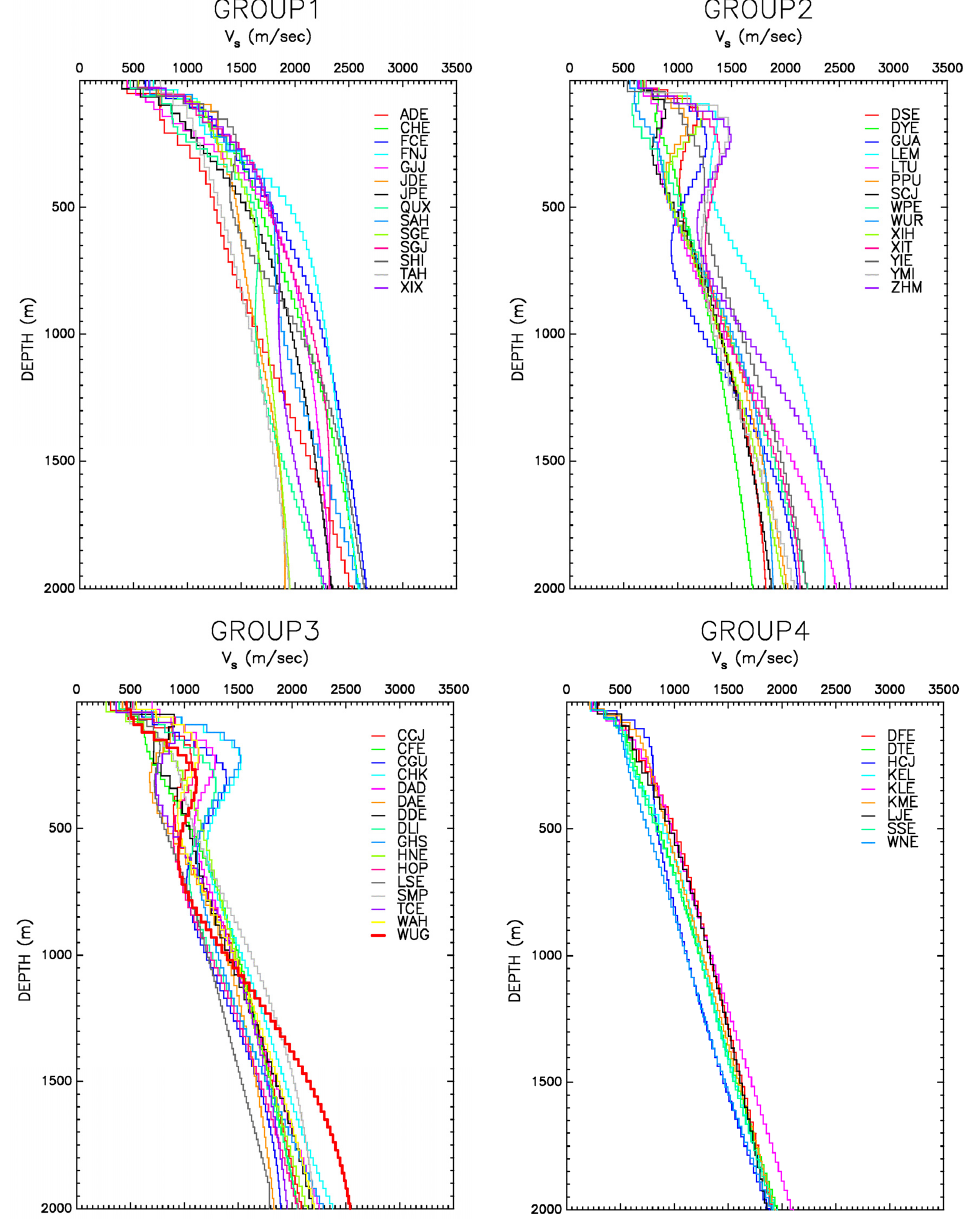
Figure 10. S-wave velocity structures estimated using the surface-wave inversion technique (Herrmann [22]) at all 53 sites. To elucidate the variation of the shallow S-wave velocities in the Taichung area, we include contour maps of the S-wave velocities at depths of 50–1800 m in Figure 11, based on the results of Figure 10. The contour maps indicate the presence of lateral heterogeneity and that velocities change with depth. The results are as follows: (1) Depths of 50–300 m: The highest velocities appear at the central part (YMI), whereas the lowest velocities appear at the western part (WNE). The area with the highest S- wave velocities gradually shifts from the central part (YMI) to the northeastern part (SGJ) as depth increases. (2) Depths of 300–600 m: The area with the highest S-wave velocities gradually shifts from the central part (SGJ) to the eastern part (FNJ), which is near the Chelungpu Fault, as depth increases. The lower velocities still appear at the western part (WNE). (3) Depths of 600–1200 m: The highest velocities appear at the eastern part (FNJ, FCE), whereas the lower velocities appear at the western (WNE) and southwestern (HCJ) parts. (4) Depths of 1200–1800 m: The highest velocities remain at the eastern part (FNJ, FCE). The second highest velocity zone appears at the area near sites SHI and ZHM. Similarly, the western part (WNE, HCJ) still exhibits the lowest velocities.